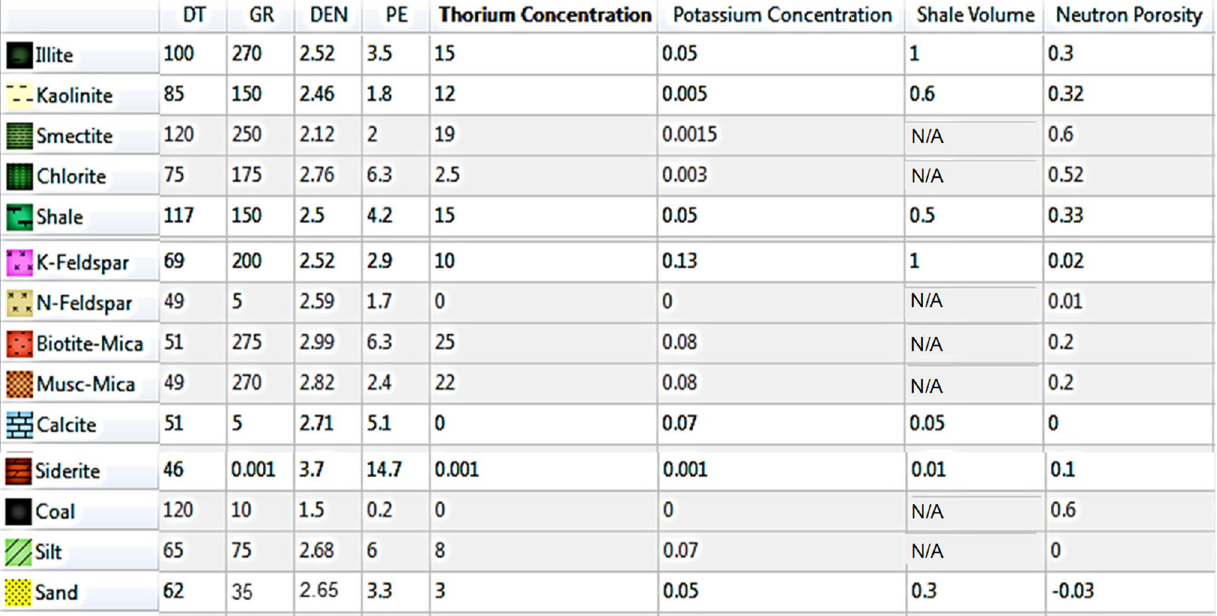
Table 5 Summary of input parameters of Quanti-Elan